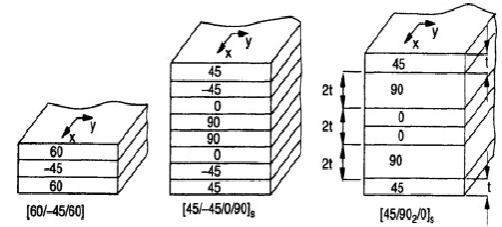
Figure 9. Flutter binary model